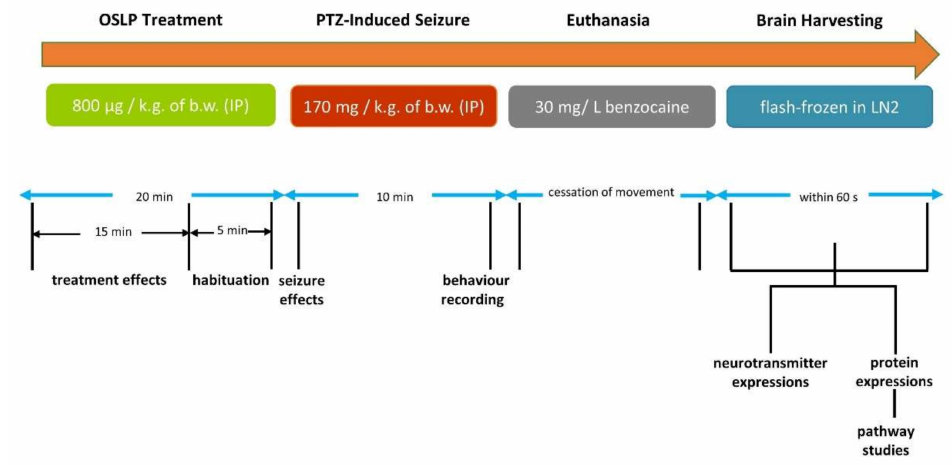
Figure 1. Shows the procedures of experiment.